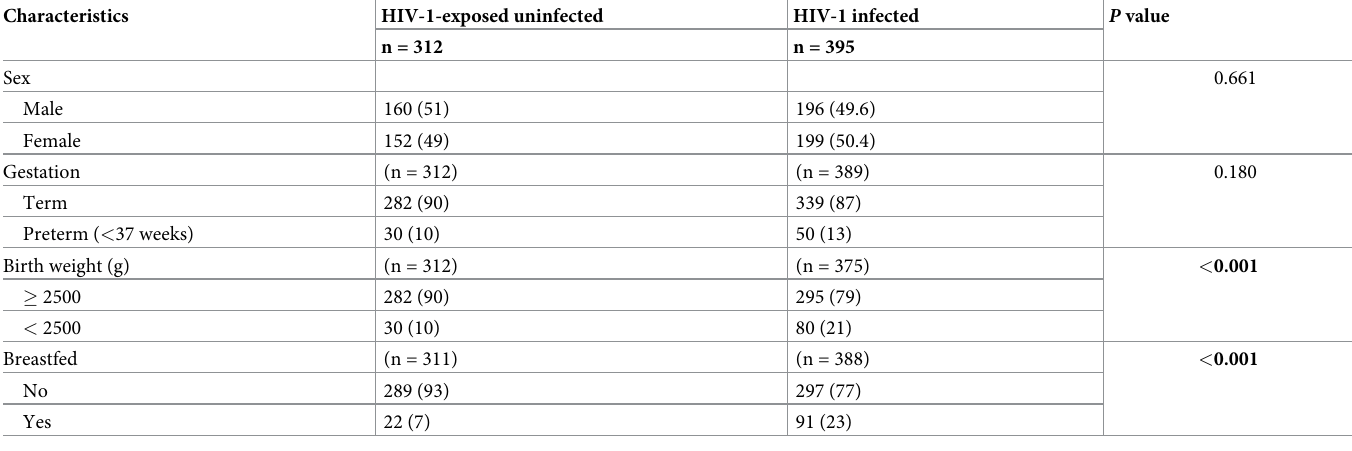
Table 1. Characteristics of perinatal HIV-1 acquisition in our study cohort.